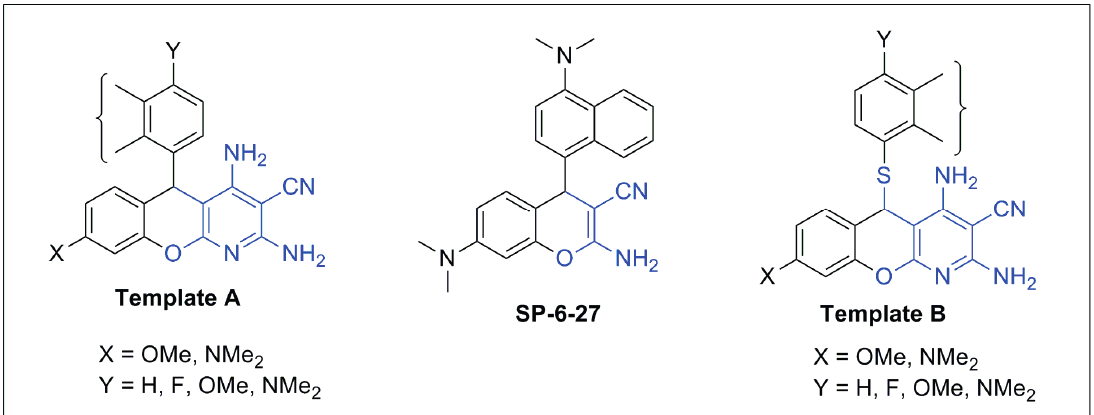
Figure 2. Hypothesized